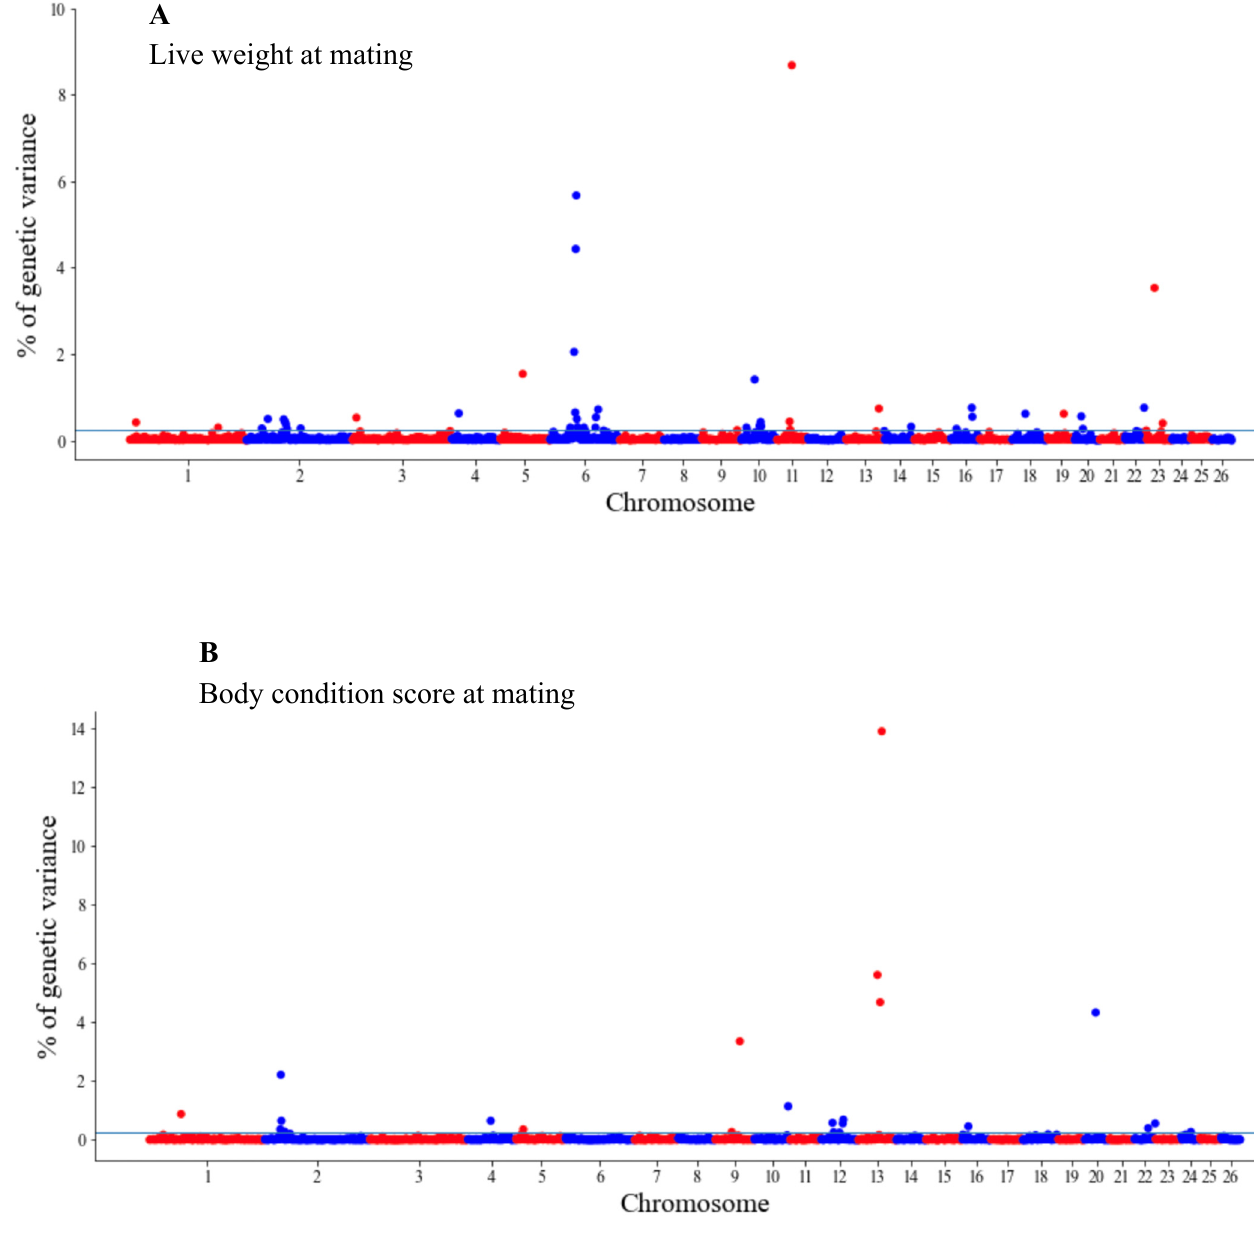
Figure 2. Manhattan plots of the genetic variance explained (%) by 20 adjacent SNP windows for the ewe live weight ( A ) and body condition score at mating ( B ). Each dot represents a window. The % of additive genetic variance explained by each window and chromosomes 1–26 are shown on the Y -axis and X -axis, respectively. The horizontal line indicates the suggestive threshold of 0.25% of the PVE. For the wool traits, a total of 35 windows (13 for FD and 22 for CFW) surpassed the significance threshold (PVE ≥ 0.25%, Figure 1). The proportion of the total additive genetic variance explained by these windows was 4.85 and 9.06% for FD and CFW, respectively. There were 42 windows significantly associated with LWM, which collectively explained 43.2% of the additive genetic variance. For BCS, 22 relevant windows accounted for more than 40% of the additive genetic variance (Figure 2). For the reproduction traits, 53 genomic windows (24 and 29 for PR and LP, respectively) reached the suggestive threshold of 0.25% of the PVE (Figure